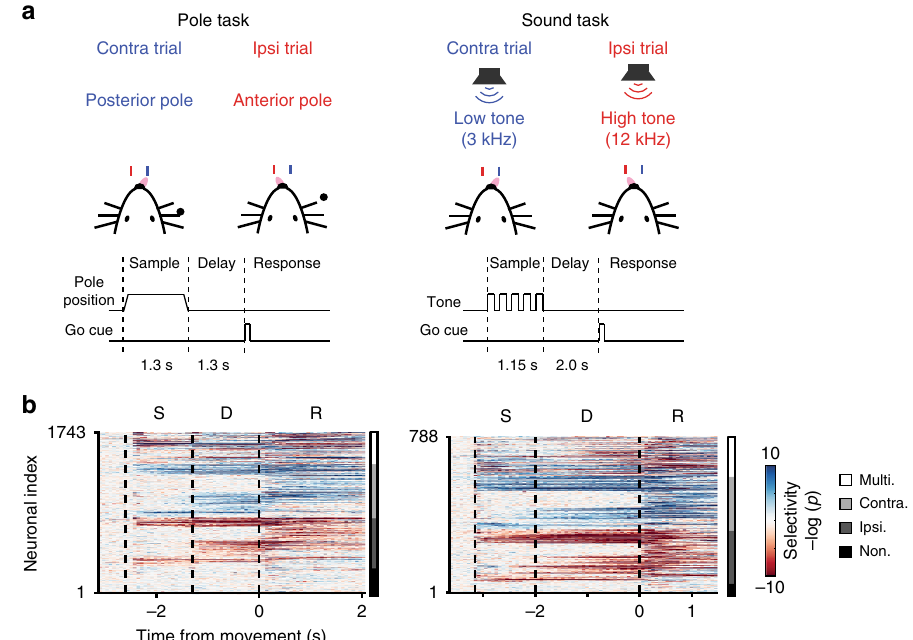
Fig. 1 Neural activity of anterior lateral motor cortex neurons exhibits complex, heterogenous activity. a Schematic description of experiments. Mice were trained to report pole position (left) or frequency of tone (right) by directional licking, following a delay period after the end of stimulus presentation (contra trial, lick right; ipsi trial, lick left). b Heatmap of instantaneous trial-type selectivity, displayed as negative log of p -value (two-sample t -test), (blue: contra-preferring; red: ipsi-preferring). For visual clarity neurons were sorted by response category, shown in bar on right (black, non-selective; dark gray, ipsi-monophasic selective; light gray, contra-monophasic selective; white, multiphasic selective, where neurons show strong switches of selectivity during a